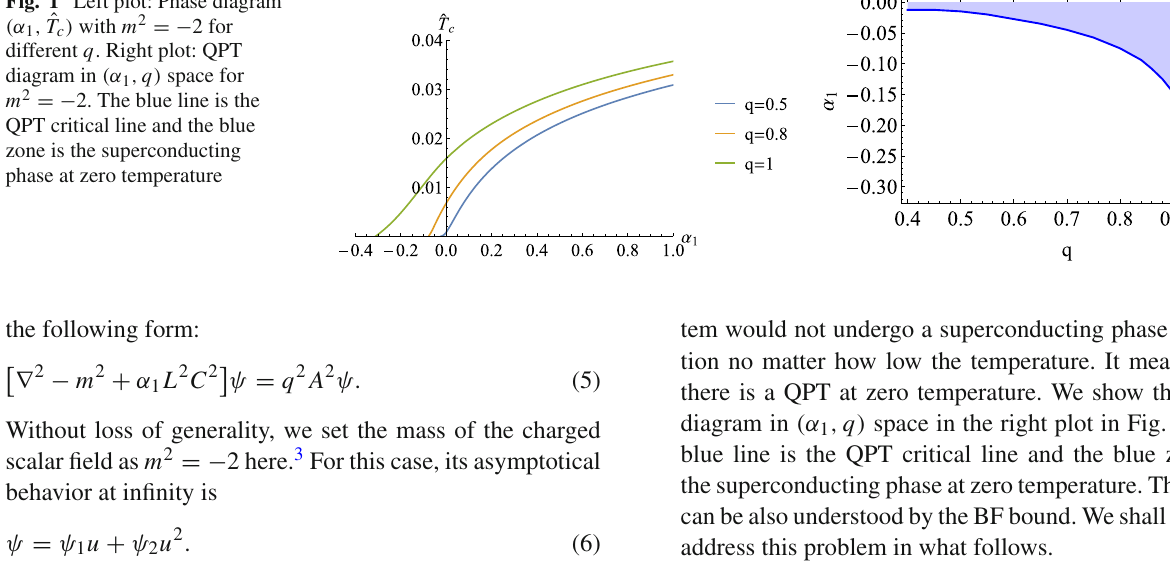
Fig. 1 Left plot: Phase diagram (α , ˆ T ) with m 2 = − 2 for c 1 different q . Right plot: QPT diagram in (α 1 , q ) space for m 2 = − 2. The blue line is the QPT critical line and the blue zone is the superconducting phase at zero